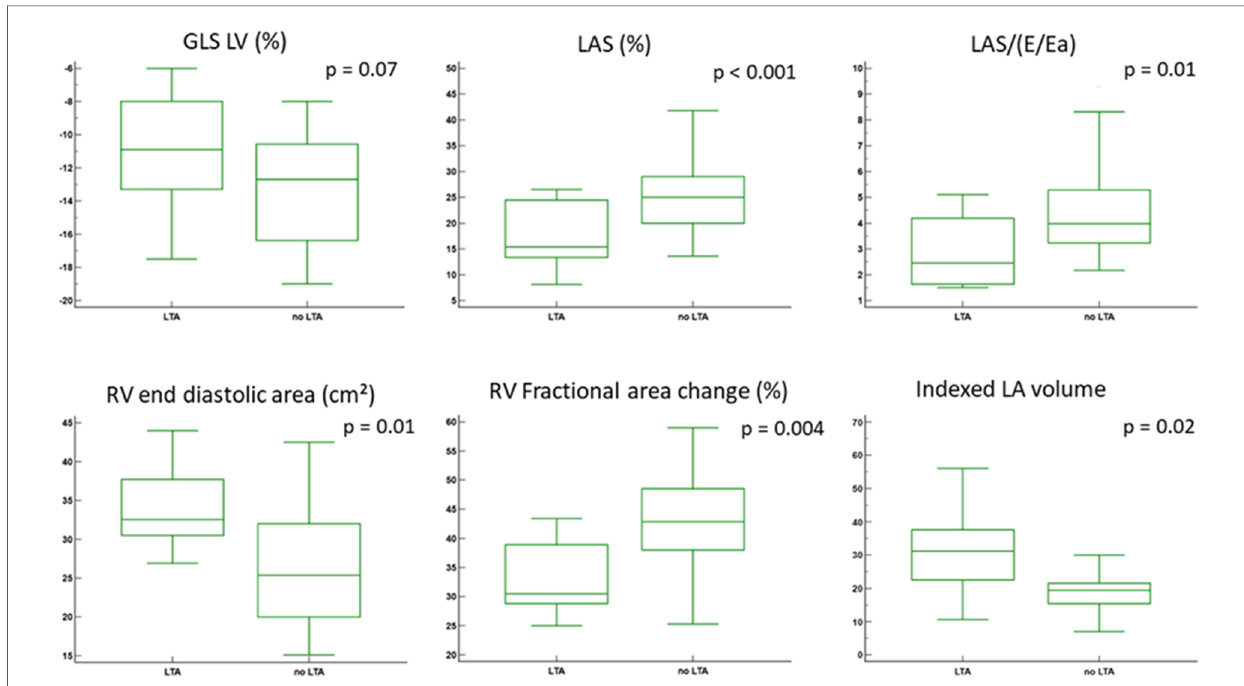
FIGURE 2 Comparisons of echocardiographic parameters according to h-LTA. GLS, global longitunal strain; LV, left ventricle; RV, right ventricle; LAS, left atrial strain.